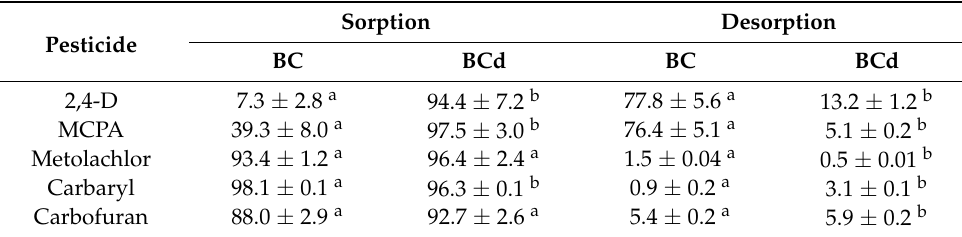
Table 4. Sorption and desorption magnitude of 2,4-D, MCPA, metolachlor, carbaryl and carbofuran on pristine (BC) and deashed biochar (BCd). Results are expressed as mean values ± standard deviation ( n = 3).